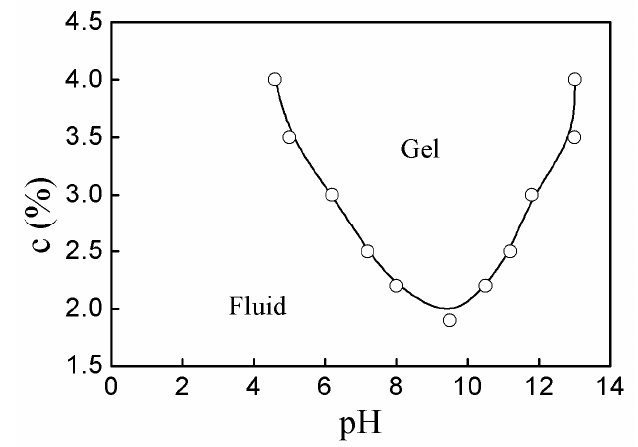
Figure 7. The phase diagram of the aqueous dispersion of P(AA- co -VAm) microgels.